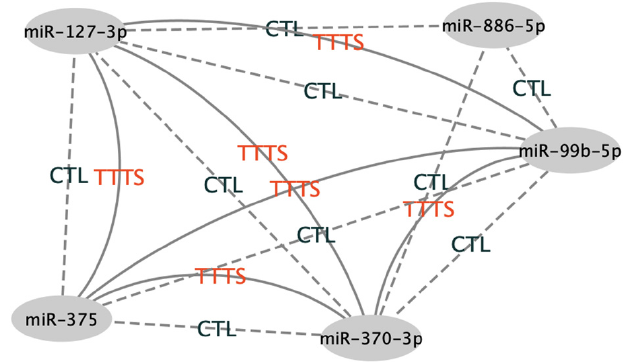
Figure 5. Network Figure 5. Network analysis .